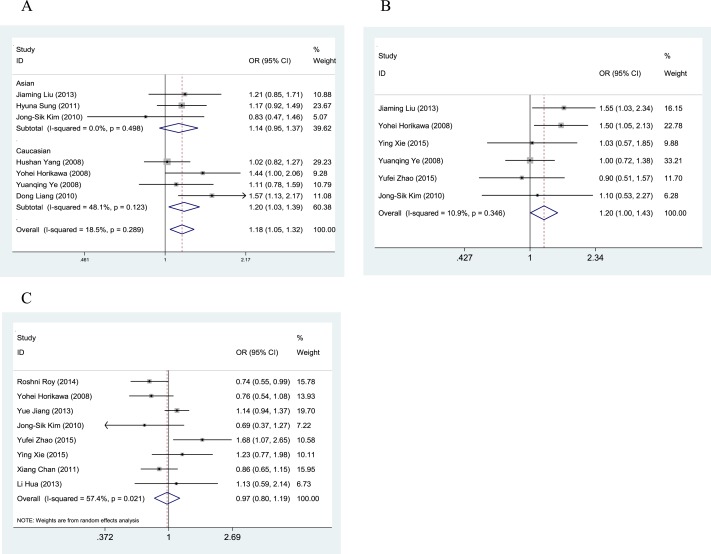
Forest plots of the relationship between cancer and Gemin4 rs7813 (A), Gemin4 rs2740348 (B) and Gemin3 rs197412 (C).